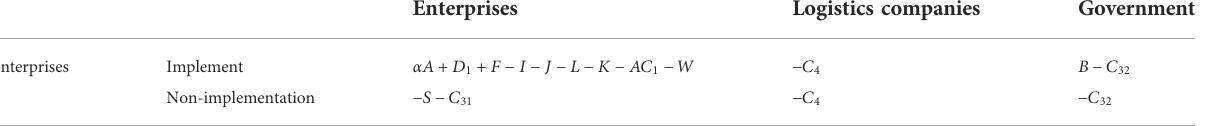
TABLE 5 Game matrix with no government participation and no logistics company participation. Enterprises Logistics companies